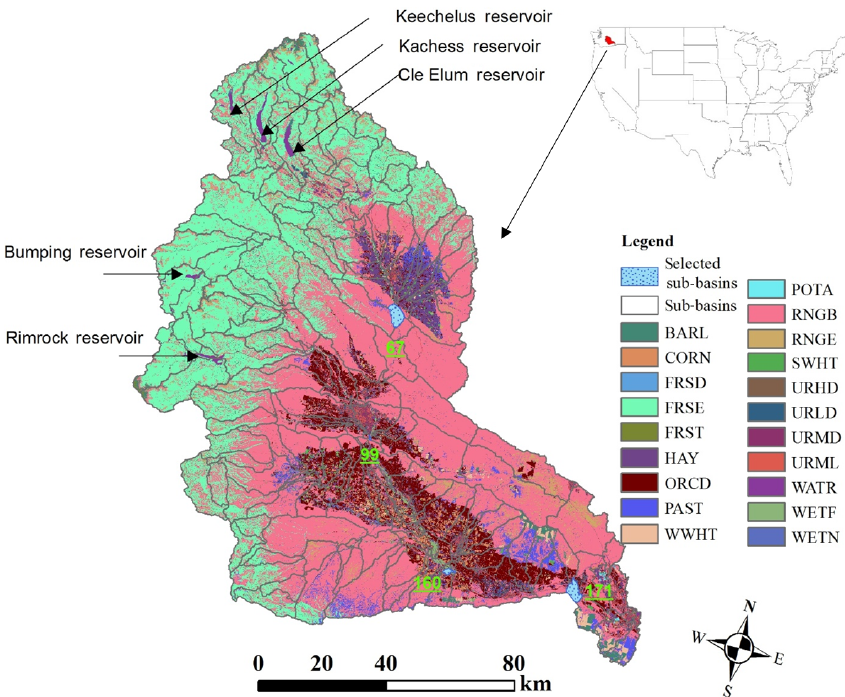
Figure 1. Location and land use of the Yakima River basin (67, 99, 160, and 171 are sub-basins used for streamflow calibration and valida- tion). BARL: spring barley; CORN: corn; FRSD: deciduous forest; FRSE: evergreen forest; FRST: mixed forest; HAY: hay; ORCD: orchard; PAST: pasture; POTA: potato; RNGB: range bush; RNGE: range grasses; SWHT: spring wheat; URHD: residential – high density; URLD: residential – low density; URMD: residential – medium density; WATER: water; WETF: wetland – forested; WETN: wetland – non-forested; WWHT: winter wheat). Table 1. Reservoir information of the YRB’s five reservoirs (locations are marked in Fig. 1). Reservoir River Completion Dam Active